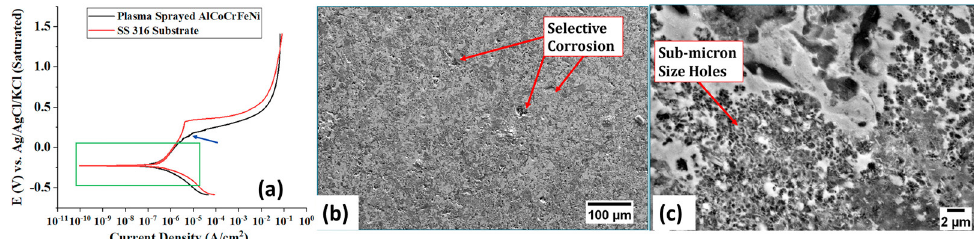
Figure 15. ( a ) Potentiodynamic polarization curves of APS AlCoCrFeNi HEA coatings and SS 316L and ( b , c ) depict the corroded HEA surfaces [68].